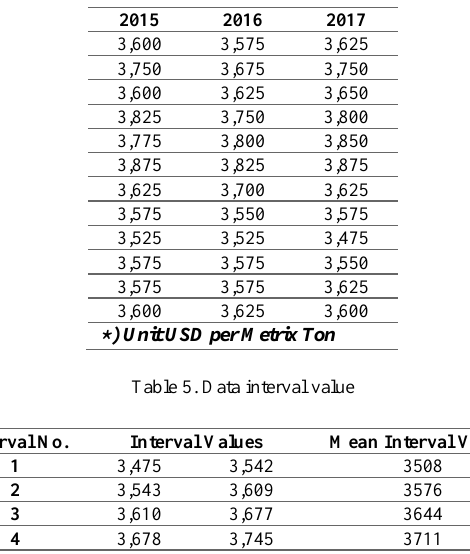
Table 4. Purchase price data (2015-2017)